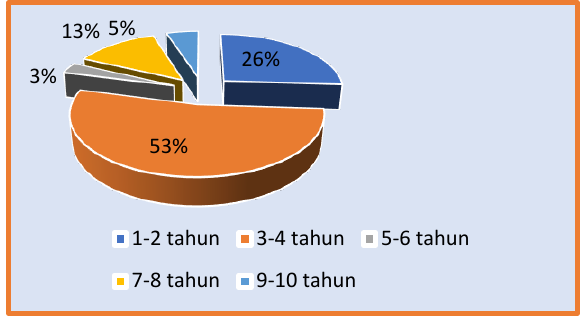
Figure 1 Respondents Based on the Membership Period Source: Summary of Results of research Data